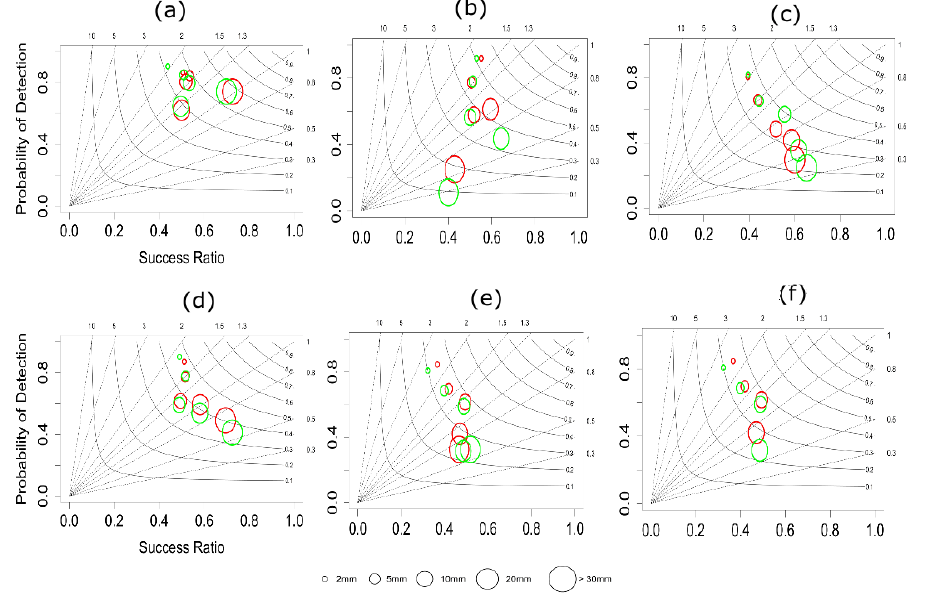
Figure 13. Categorical verification technique (performance diagram) showing the Success Ratio (SR), Probability of Detection (POD), BIAS, and CSI values of TRMM (red) and GPM (green) for the year ( a ) 2016, ( b ) 2017, and ( c ) 2018 and for subdivisions ( d ) Northern, ( e ) Dhofar, and ( f ) Interior of Oman. The circles represent different monthly precipitation thresholds, ranging from low (<2 mm) to high (>30 mm) rain. Solid contours represent the CSI, while dashed lines represent the BIAS.